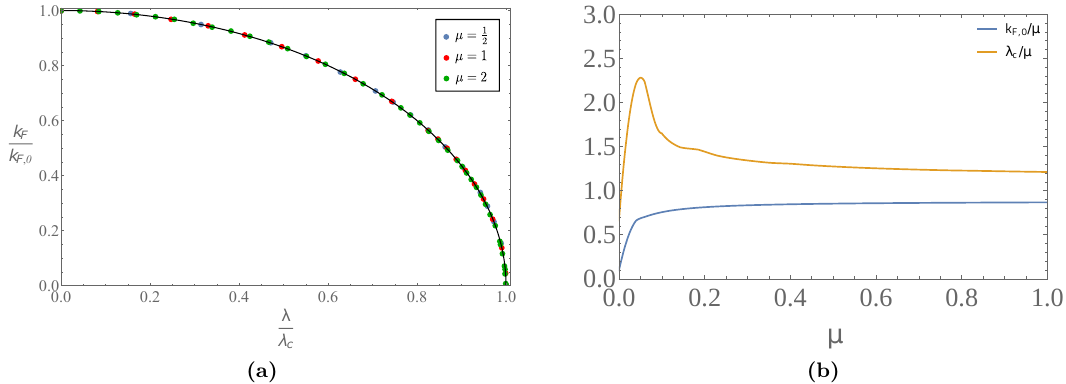
Figure 10 . (a) The Fermi momentum k F corresponding to the holographic Green’s function in alternative quantization as a function of the coupling (cid:21) . The Fermi momentum is scaled with its value at (cid:21) = 0 and the coupling (cid:21) is scaled with the value (cid:21) c at which the Fermi surface vanishes. The black curve corresponds to eq. (3.10). (b) The Fermi momentum at (cid:21) = 0 and the critical coupling (cid:21) c , both scaled with the chemical potential (cid:22)